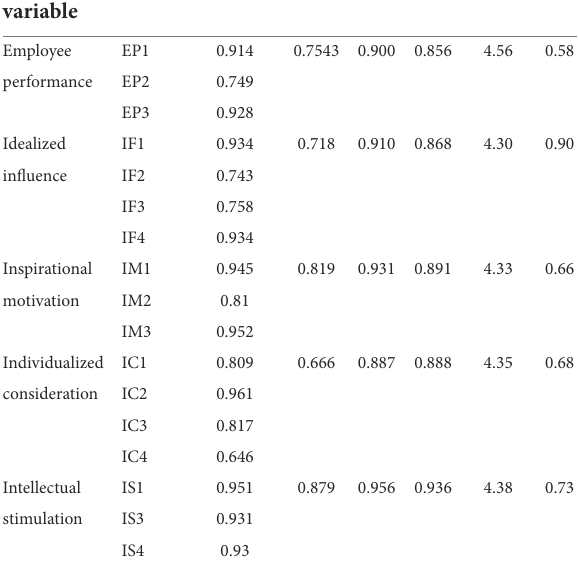
TABLE 2 Results of measurement model assessment. Items Loading AVE CR